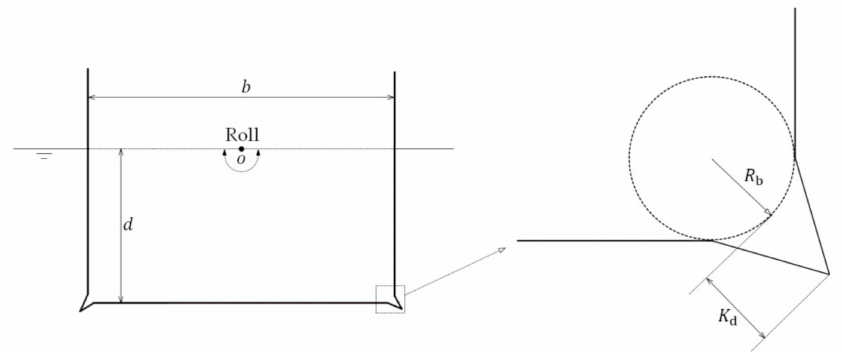
Figure 2. A rectangular hull section with bilge keels harmonically rolls on the water surface, with beam b = 0.4 m, mean draught d = 0.2 m, bilge radius R b = 0.02 b , bilge keel depth K d = 0.04 b , and roll amplitude θ = 0.05 rad. The rotation axis is located at the center of